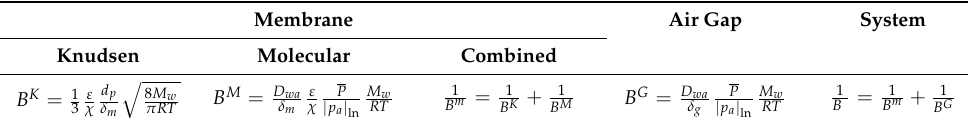
Table 3. Vapor permeabilities in membrane and air gap. Membrane Air